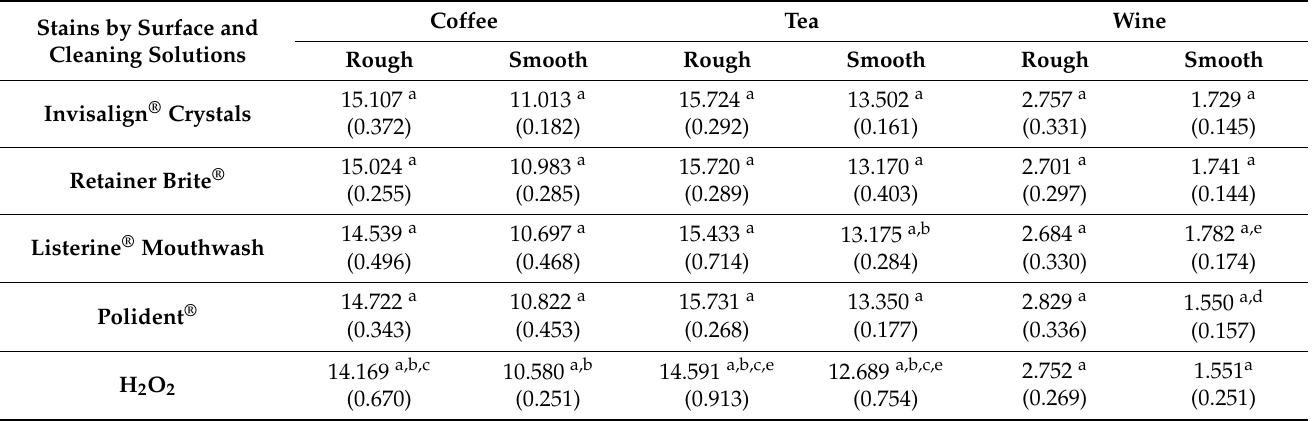
Table 6. NBS values for copolyester retainer specimens with different surface textures stained in coffee and tea solutions and then destained with five different cleaning solutions (mean NBS value ± standard